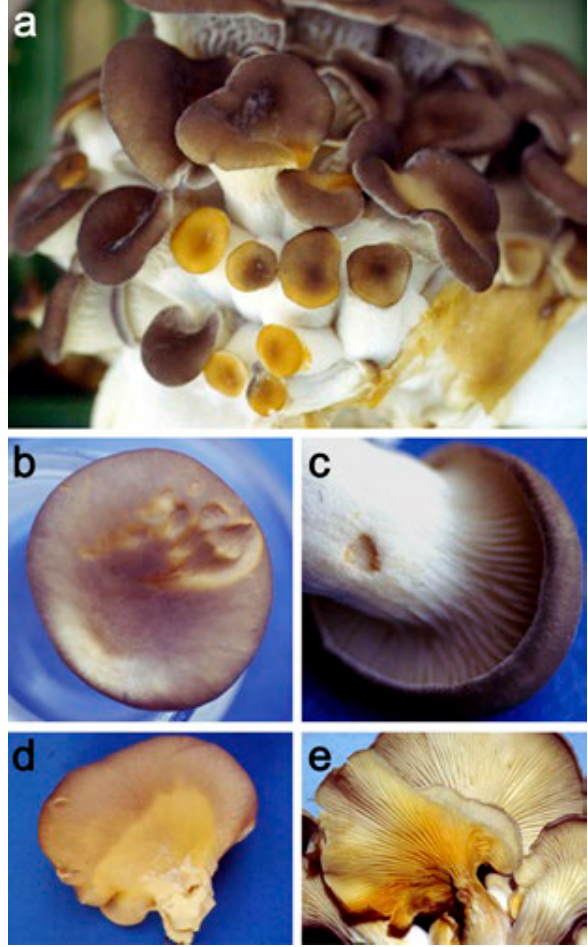
Figure 1. Symptoms of yellowing and/or brown-reddish blotch on Pleurotus ostreatus sporocarps. Yellow-orange su- perficial discoloration on developing sporocarp bunches were followed by cessation of growth, withering and tis- sue rot (a), brown-reddish blotches surrounded by yellow discoloration on cap (b) and stipe (c), yellow superficial lesions on cap (d) and gill (e).